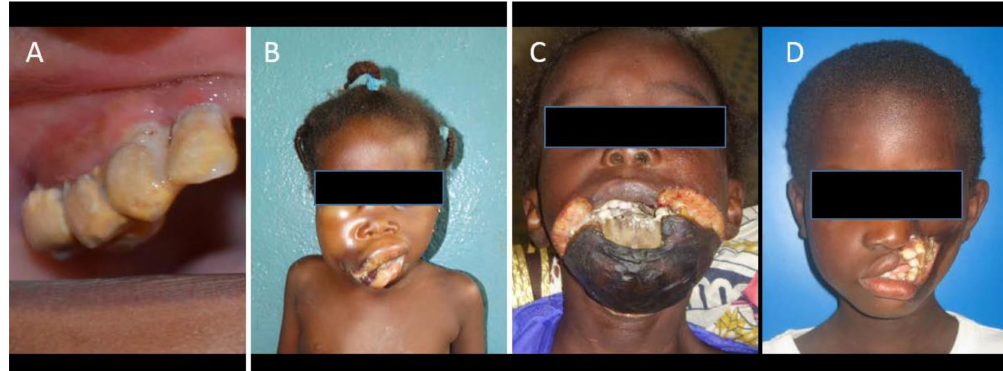
Figure 1. ( A ) Acute necrotizing gingivitis with the presence of a huge amount of calculus, greyish deposits, and decapitation of gingival papillae; ( B ) stage 2 (oedema) in a young Malian girl. Oedema of the right cheek can be observed with incipient necrosis starting at the lip angle; ( C ) stage 3 (necrosis) in a Malian boy. The chin and the adjacent region are necrotic, with exposure of mandibular necrotic bone in the middle. The detachment of the margins of the necrotic tissue from the surrounding healthy regions can be observed; ( D ) stage 5 (sequelae) in a girl presenting loss of tissue a ff ecting the left cheek and both